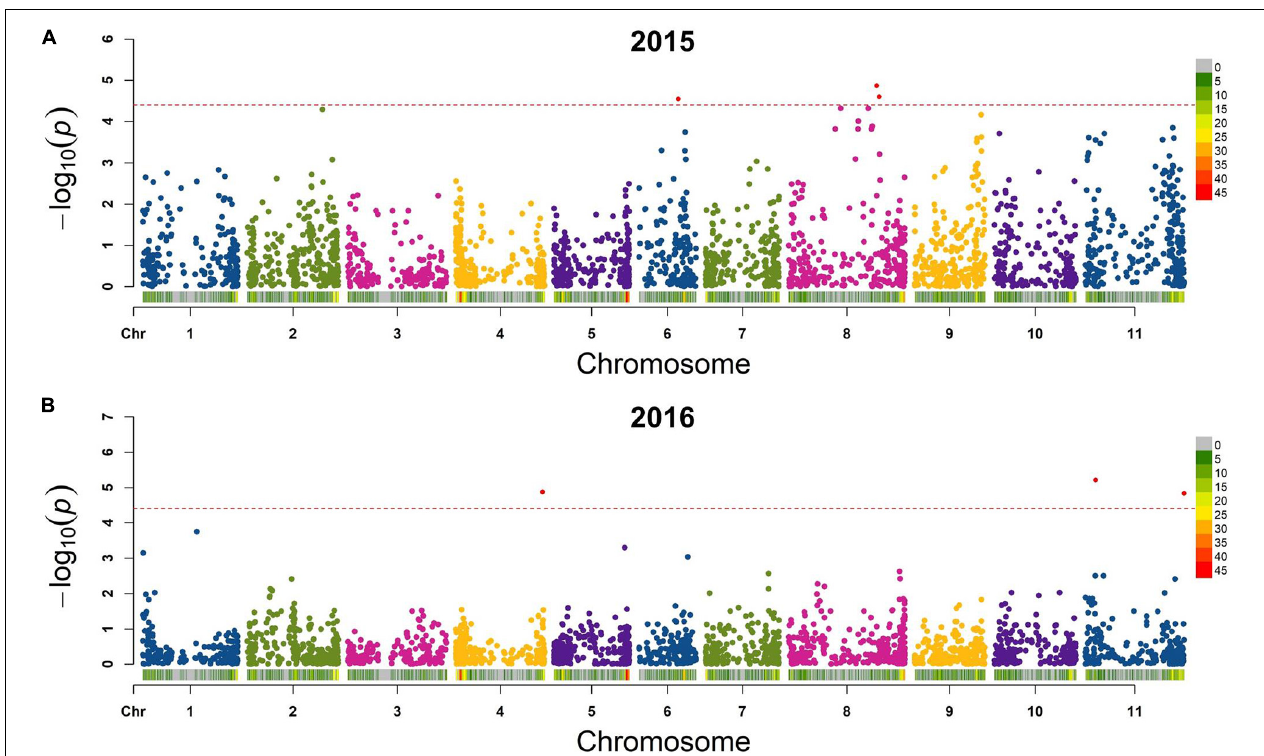
FIGURE 5 | Manhattan plots of QTL for total seed folate content in the diversity panel that were detected by GWAS with the FarmCPU model in rMVP. (A) Plots based on 2015 data. (B) Plots based on 2016 data. The significance threshold is indicated by a dashed line on each plot, and markers above the significance threshold are colored red. SNP density is indicated in the legends to the right of each